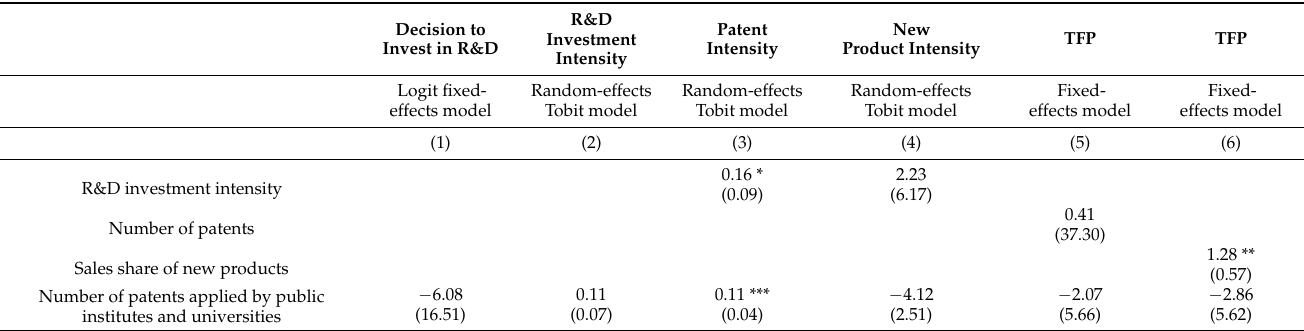
Table A1. Original coefficient of R&D investment, innovation output, and productivity